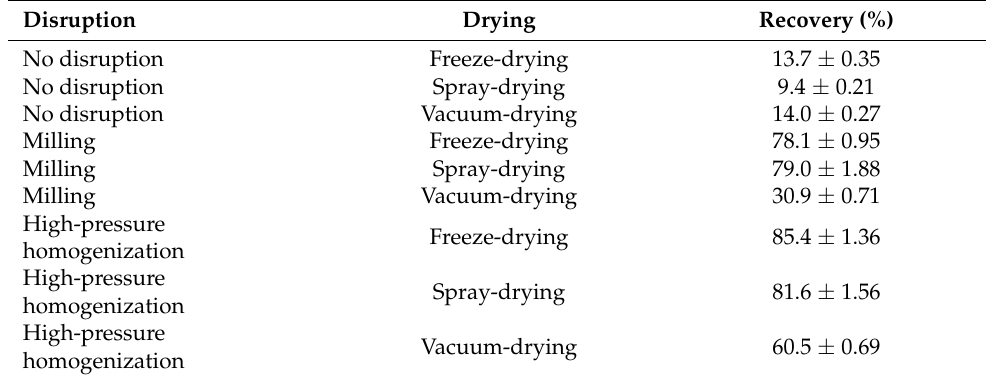
Table 2. Total astaxanthin recovery after SC-CO 2 extraction compared with the initial astaxanthin content of the sample, depending on the previous disruption and drying methods.